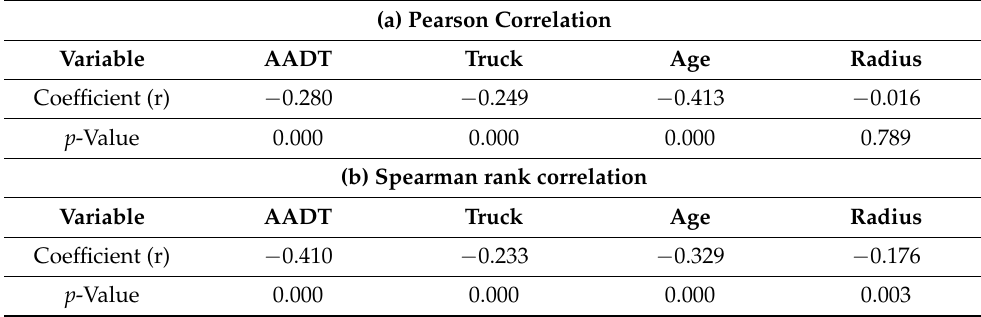
Table 5. Summary of correlation analysis results.